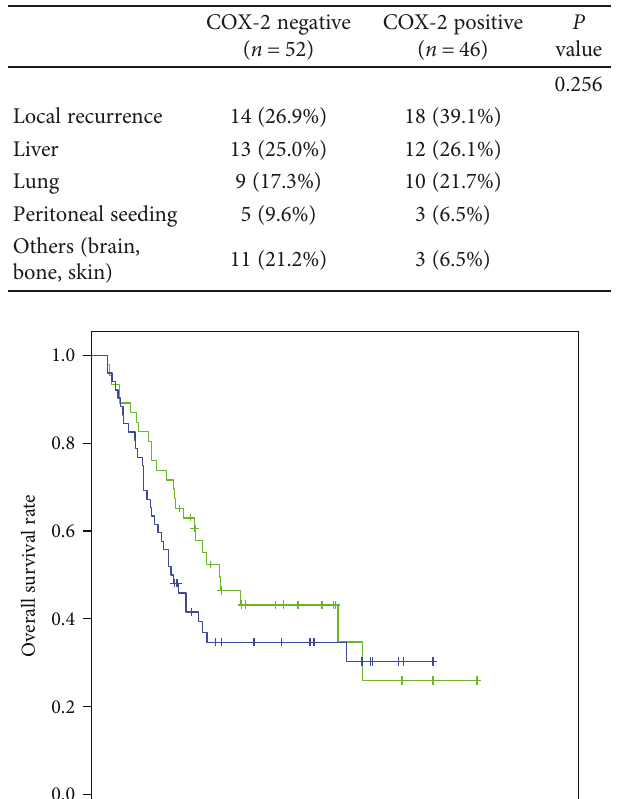
Table 4: Recurrence pattern according to the status of COX-2 expression in the 98 patients with recurrence.